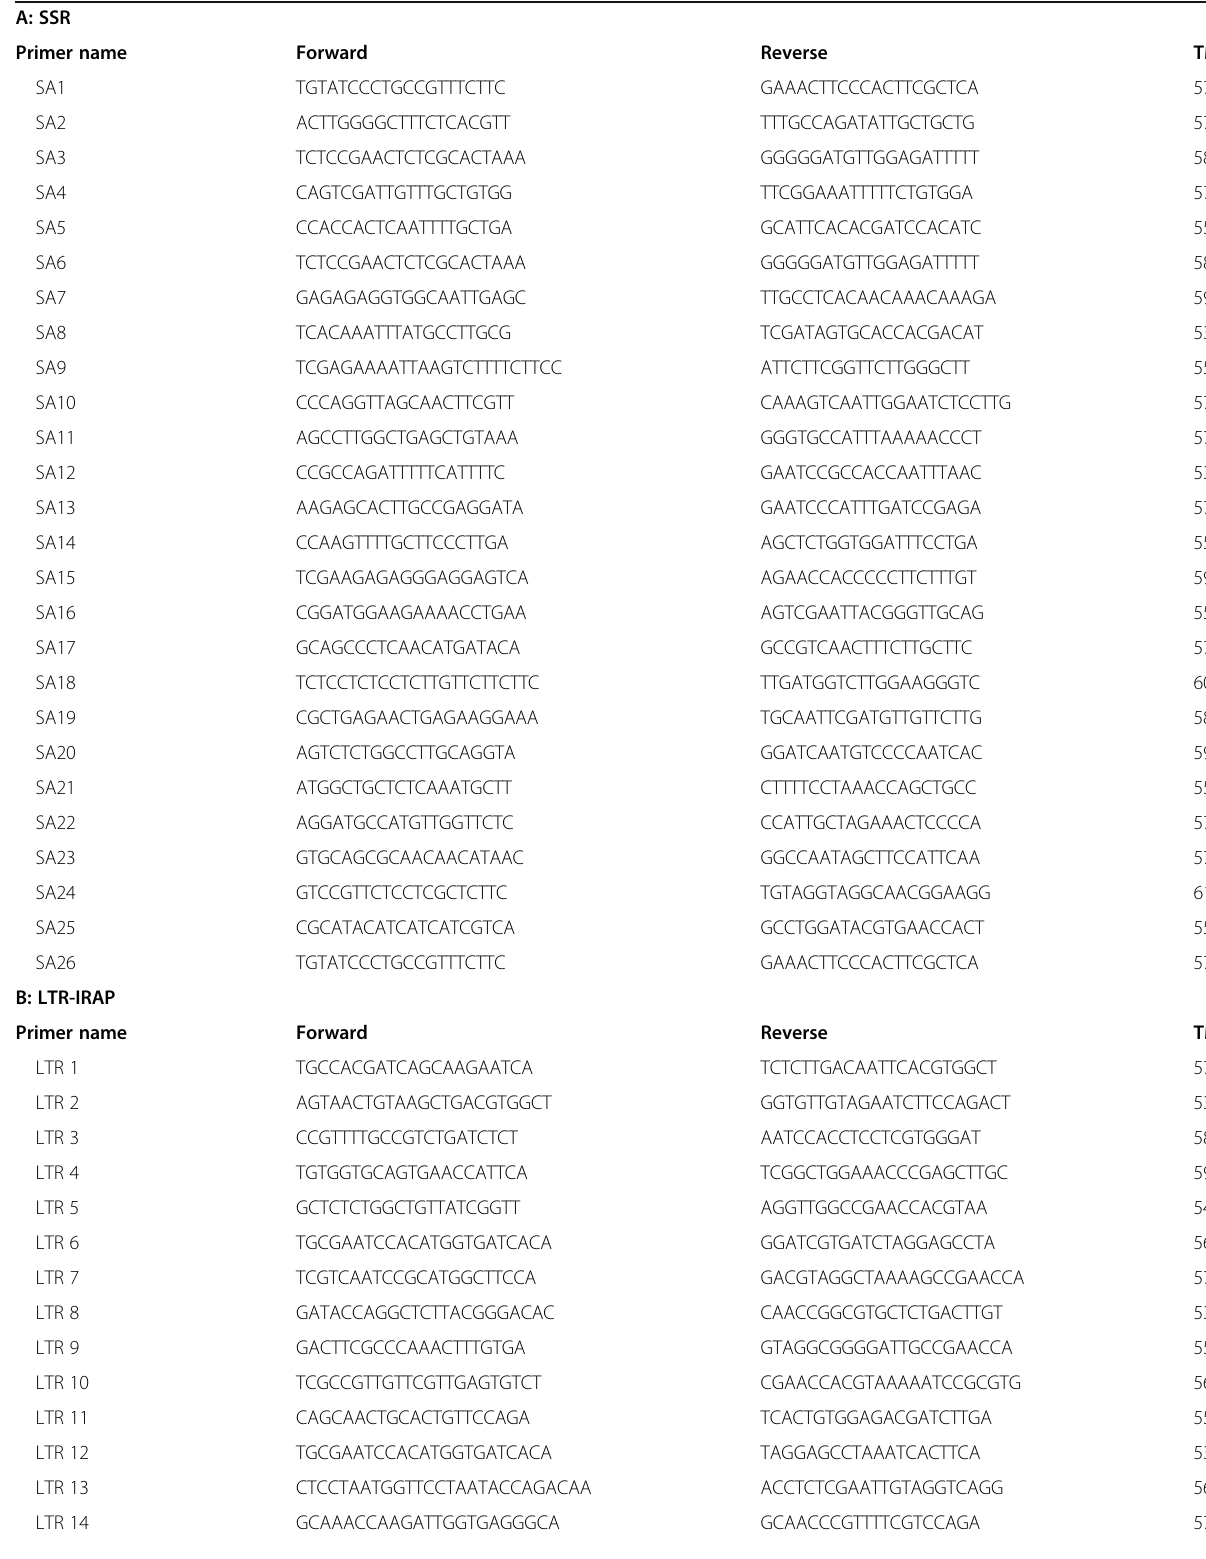
Table 2 List of SSR, LTR-IRAP, and LTR-REMAP primers sequence and its optimum annealing